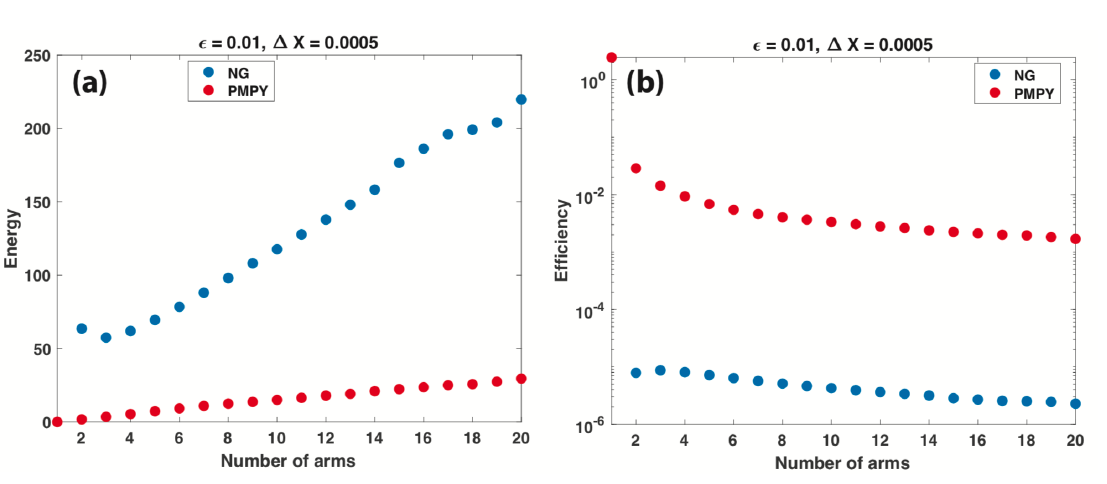
Figure 4. ( m + 1 ) -linked-sphere NG-type or PMPY-type of swimmers with widely separated spheres. ( a ) Energy dissipation of optimal strokes E ( γ ) and ( b ) efficiency Eff of NG (blue dots) and PMPY (red dots) swimmers with m linking-arms and m + 1 spheres. ε = 0.01 and X = 5 × 10 − 4 in all